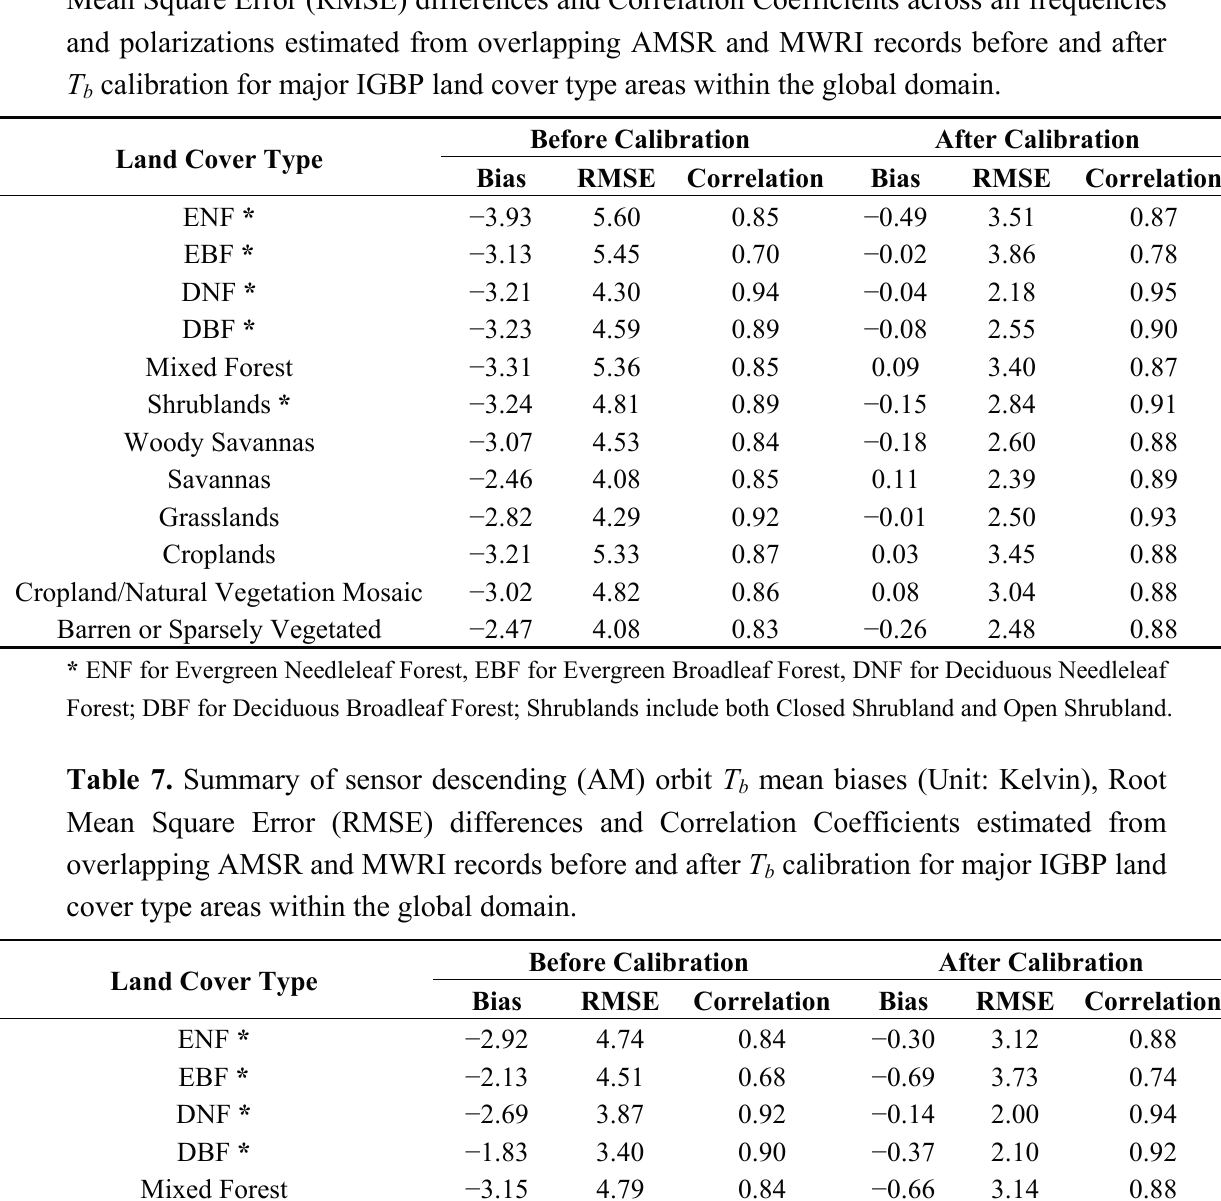
mean biases (Unit: Kelvin), Root b